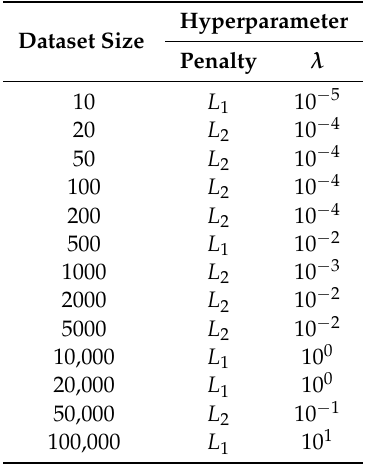
Table A1. Hyperparameters for penalized logistic regression yielding the highest validation accuracy across dataset sizes.